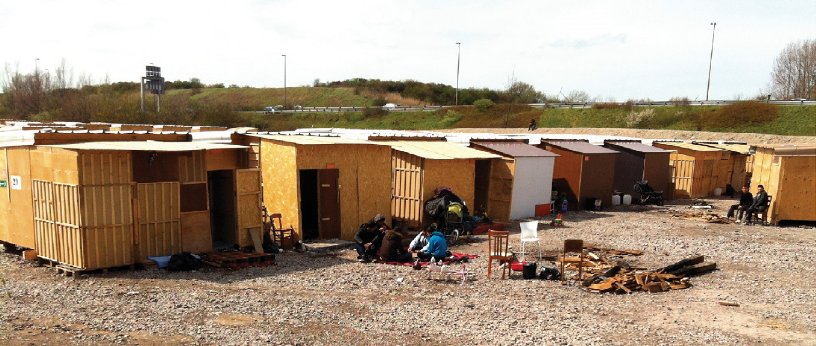
Figure 5. Extensions to huts in La Linière camp, Grande-Synthe, France, April 2016. Photo by